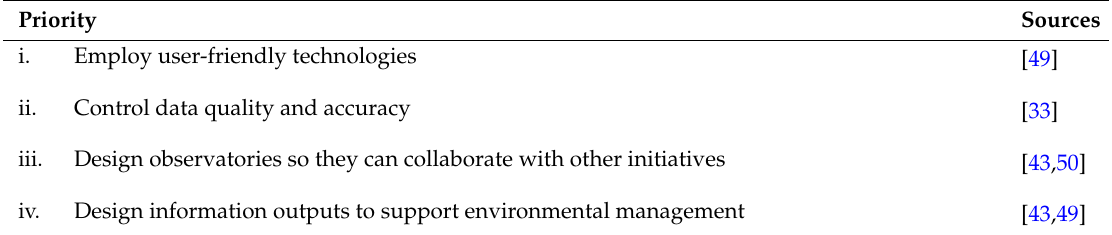
Table 2. Priorities for effective citizen